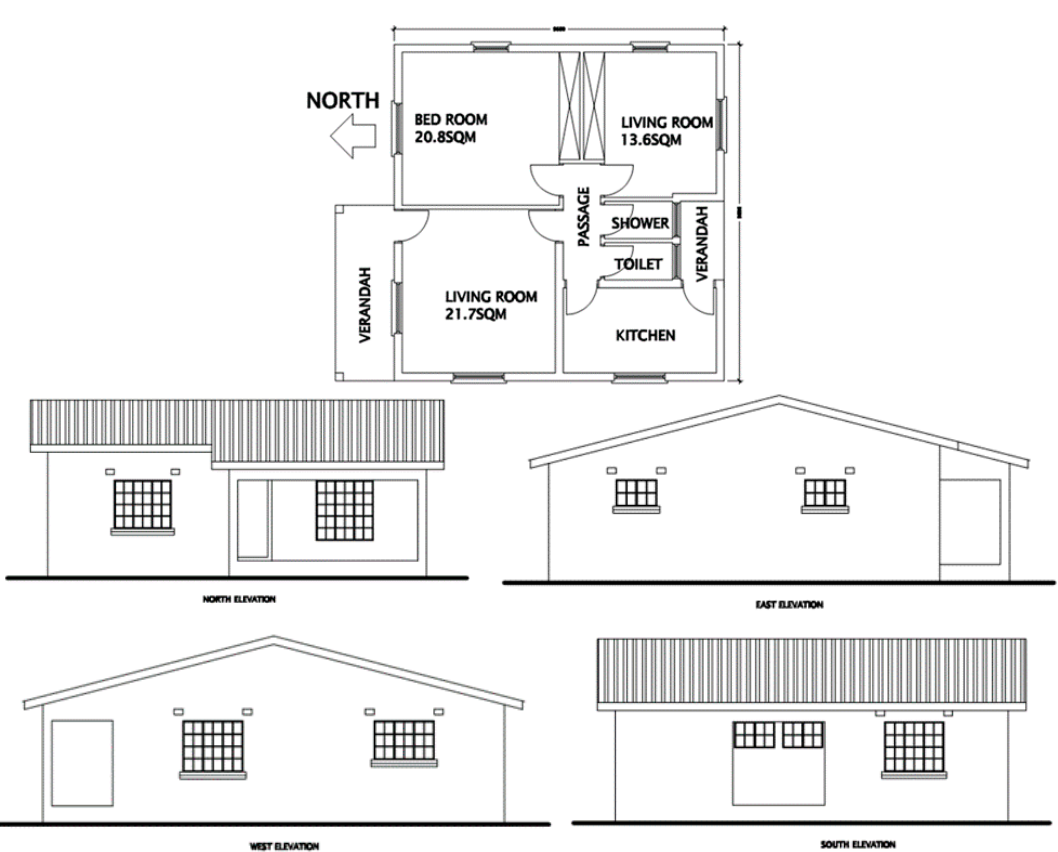
Figure 2. Floor plan and elevations of urban residential building model.